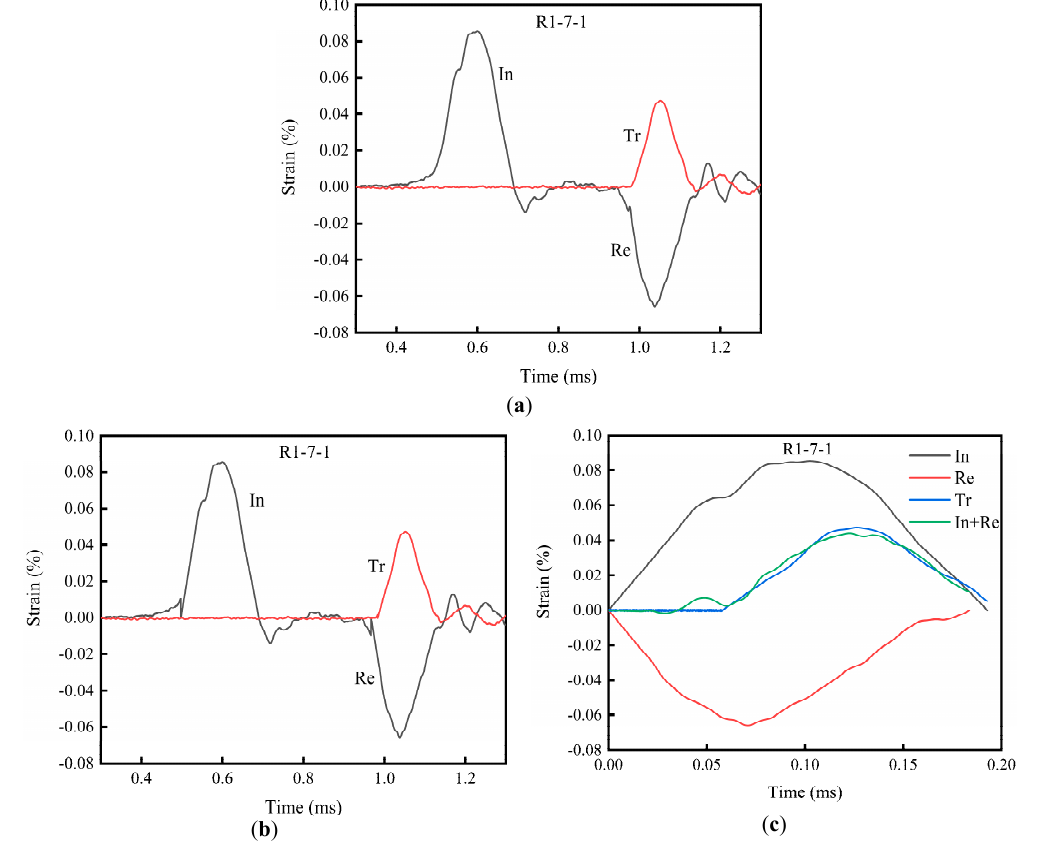
Figure 6. SHPB test wave curve processing contrast diagram (In implies Incident wave, Re implies Reflected wave, Tr implies Transmitted wave): ( a ) Original wave diagram, ( b ) wave curve processed with Li’s method [35] and ( c ) wave curve after a symmetrical wave.